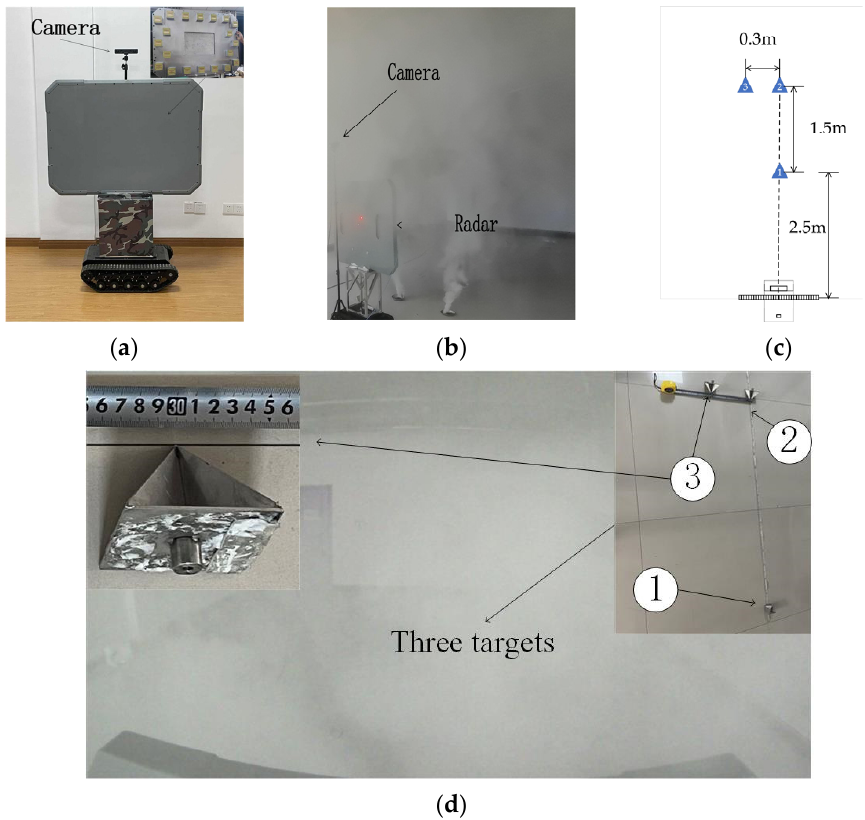
Figure 7. Optical images of experimental scenes. ( a ) MIMO radar mounted on the UGV ( b ) UGV in the fog. ( c ) Diagram of corner reflectors distribution. ( d ) Optical images of three corner reflectors in a smoky